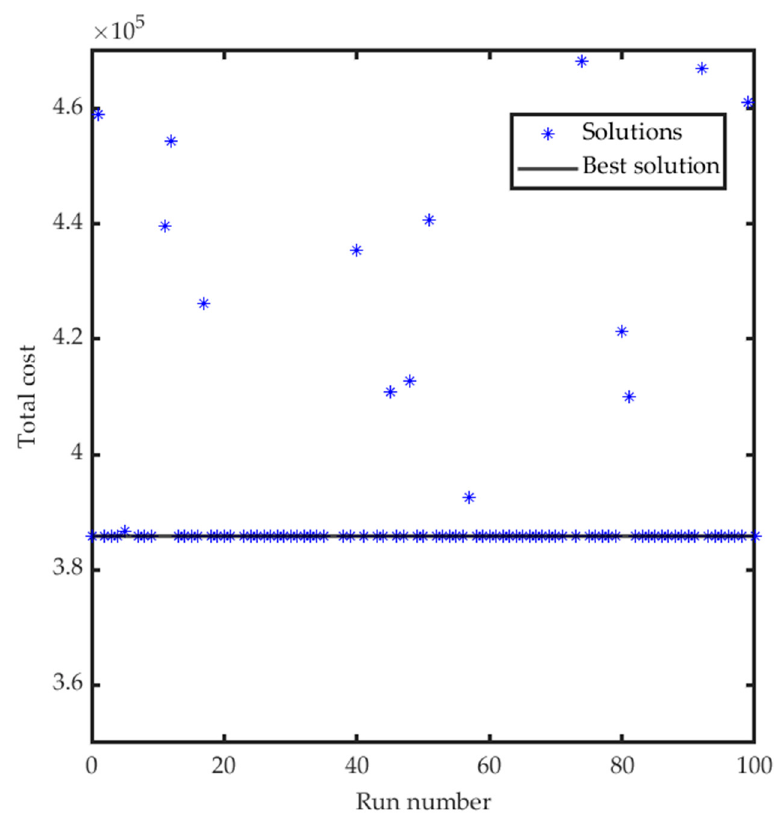
Figure 18. Solution changes for DMMFO running.